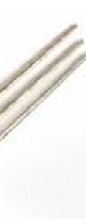
Figure 6. Tactile sensor or force resistive sensor [101]. Figure shape and orientation can also be detected using an applied magnetic field. This principle uses voltage variation values obtained from electrical conductor material. This prototype is known as the Hall Sensor. So, as the name suggests, the Hall Effect Magnetic Sensor (HEMS) given below in Figure 7 uses an applied magnetic field to measure voltage variations across the conductor. A lot of versions of the Hall sensor are used for effect measuring purposes, but mostly the unipolar MH183 is normally used. This unipolar magnetic sensor finds the relevant South Pole to perform voltage variation tasks. This lightweight sensor is placed on the tip of each finger. To measure variations, a good capacity magnet is placed onto the palm with the South Pole faced upward. When the magnet sensor is brought in front of the palm magnet, voltage variation ranging from 100 to 400 mV is generated. This prototype is known due to its high level of accuracy.